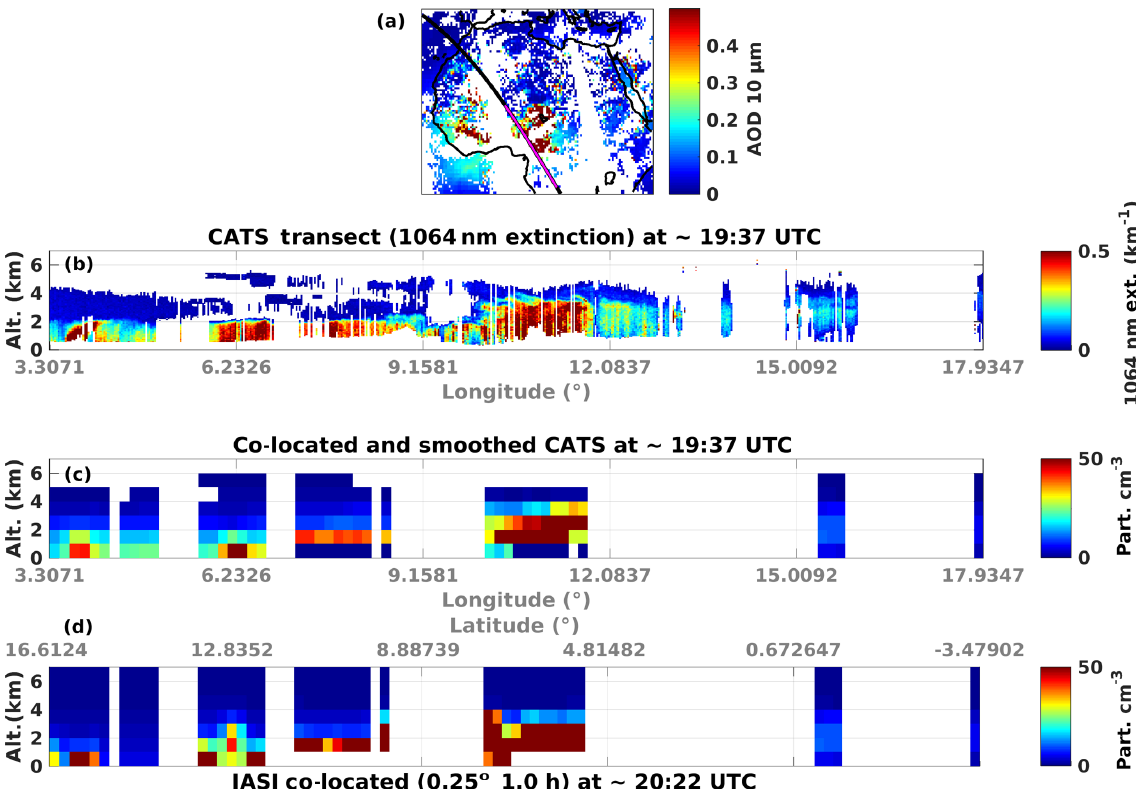
Figure 11. Mineral dust profile comparison along the CATS track on 16 February 2017. Panel (a) gives the global retrieved AOD by MAPIR together with the pathway of CATS that could be co-located with IASI in time and space. The part which corresponds to the plotted profiles below is given in pink. It covers the Sahel region. Panel (b) shows the dust extinction profiles along the pink track, as measured by CATS. In panel (c) , the CATS data smoothed according to Eq. (7) are presented, for those locations for which there is a MAPIR profile. Finally, panel (d) presents the averaged MAPIR profiles along the